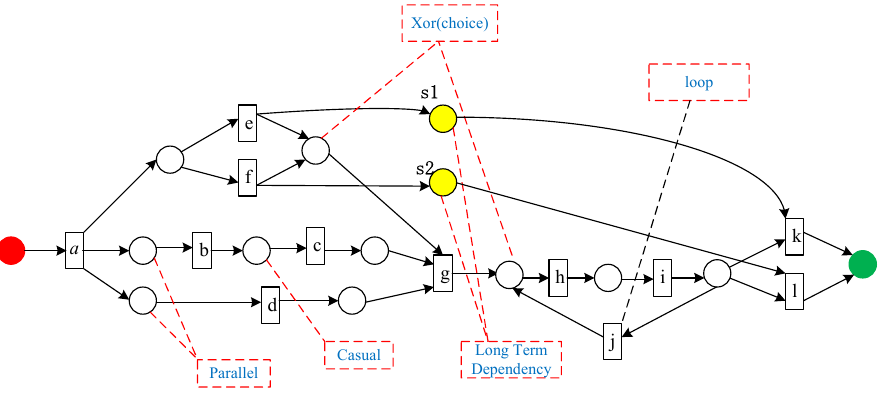
Figure 1. A Petri net with long-distance